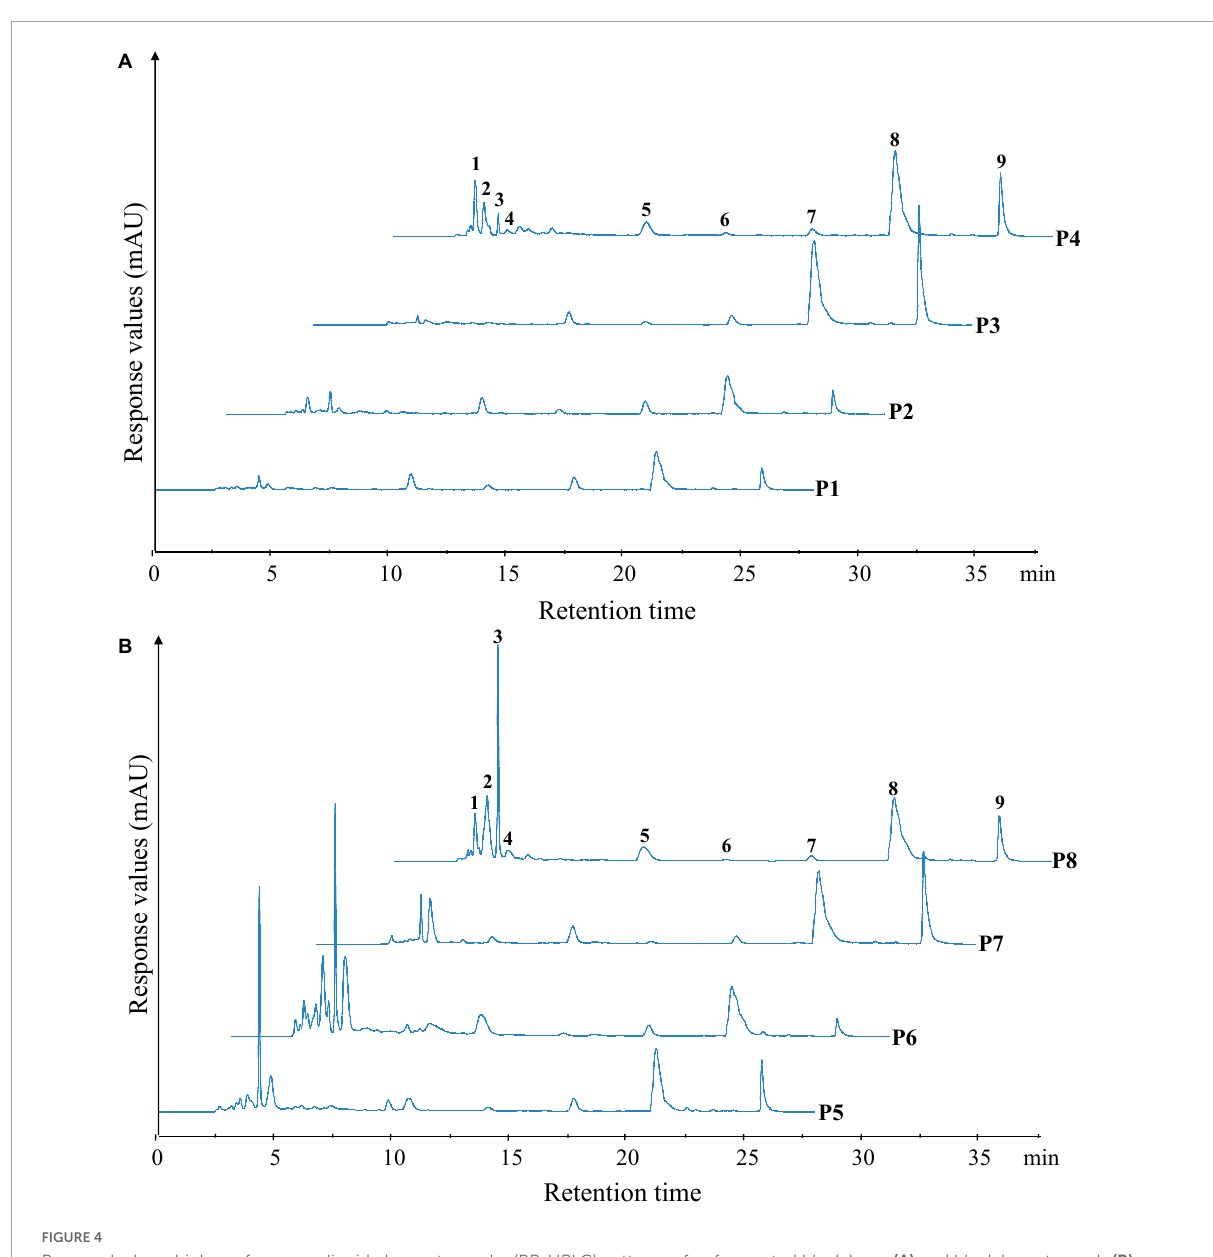
FIGURE4 Reversed-phase high-performance liquid chromatography (RP-HPLC) patterns of unfermented black bean (A) and black bean tempeh (B) samples in different simulated digestion stages. Peaks with larger areas or significant changes were successively labeled 1–9 according to their